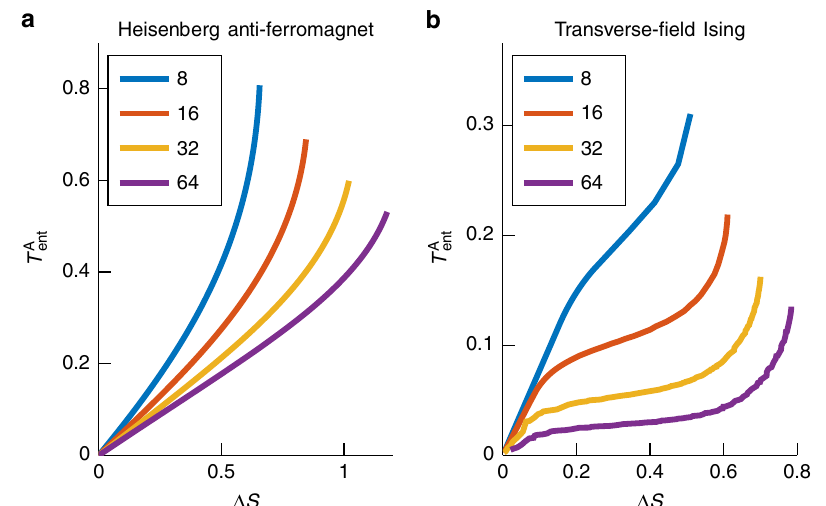
(cid:3) (cid:4) ¼ Δ E = Δ S as a function of entropy change Δ S for the critical ent / Δ S , ent